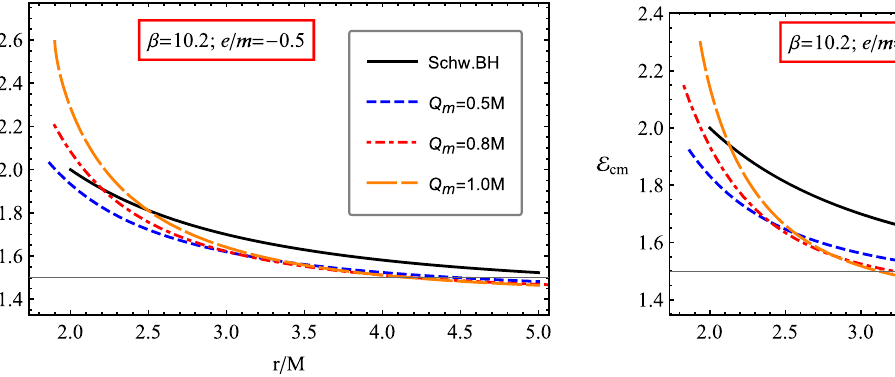
Fig. 11 Dependence of center-of-mass energy of collision of charged and magnetized particles with the same initial energy E 1 = E 2 = 1, around the magnetically charged RN black hole for the different values